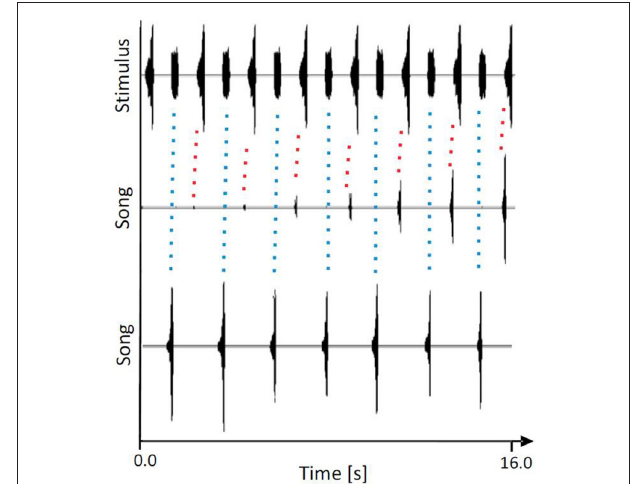
FIGURE 2 | Representative example of a M. elongata male being offered the choice to produce chirps either in synchrony with periodic conspecific chirps (higher peak amplitude in the upper trace) or white noise pulses (lower peak amplitude), presented in alternation. Note that both signals exhibited the same acoustic energy. Middle panel: song initiation. Lower panel: stable entrainment. Note the phase-locking to the chirp that was observed at the onset of the song (indicated by red-dotted lines), but was thereafter observed in synchrony with the artificial pulse (indicated by blue-dotted lines). Modified from Hartbauer et al.